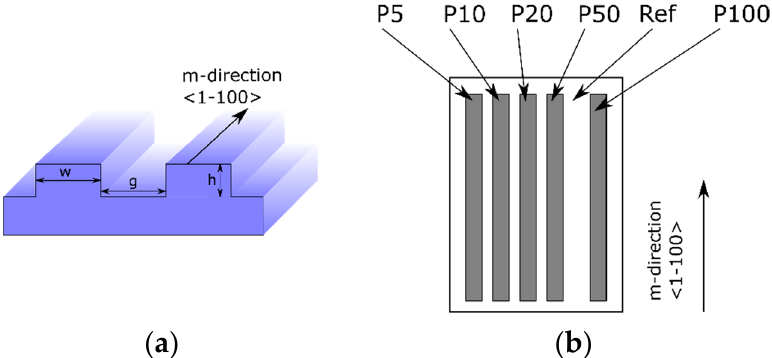
Figure 1. Stripes fabricated in GaN substrates. ( a ) Schematic perspective view and definition of stripe dimensions. ( b ) Scheme of a 11 × 14 mm c-plane (0001) GaN substrate with five patterned regions marked P5, P10, P20, P50, and P100. The stripe width (w) is 5, 10, 20, 50, and 100 µ m in regions P5, P10, P20, P50, and P100, respectively. In all regions the gap between stripes (g) was equal to the stripe width (g = w). Stripe height (h) was 4 µ m in standard samples and 1 µ m in all regions in the testing sample. The flat area named “Ref” of 1000 µ m wide, without stripes, was made as a reference. Each region P has dimensions 1.5 × 8 mm and typically is fabricated along the m-direction. Table 1. List of substrates. Symbols (cid:107) and ⊥ mean “parallel to” and “perpendicular to”, respectively.